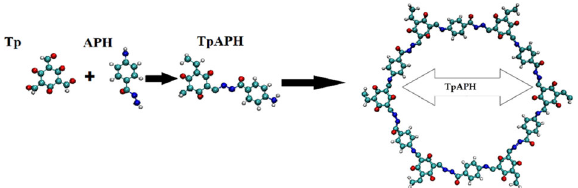
Fig. 8 Schematic representation of the formation of COF. Color code: C, cyan; O, red; N, blue; H, white.